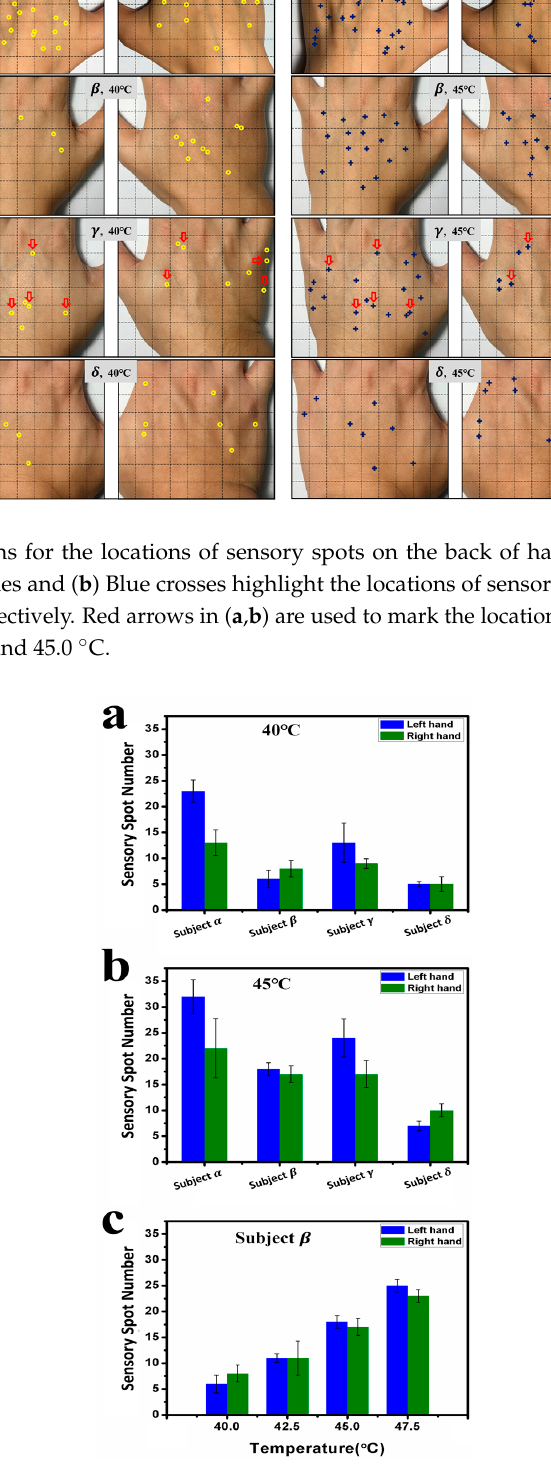
Figure 2. Statistical results of sensory spots on the back of the hands of subjects α , β , γ , and δ . Average numbers of sensory spots for four subjects responded to ( a ) at 40.0 °C and ( b ) at 45.0 °C, respectively. ( c ) Average numbers of sensory spots responded to at 40.0, 42.5, 45.0, and 47.5 °C for subject β .